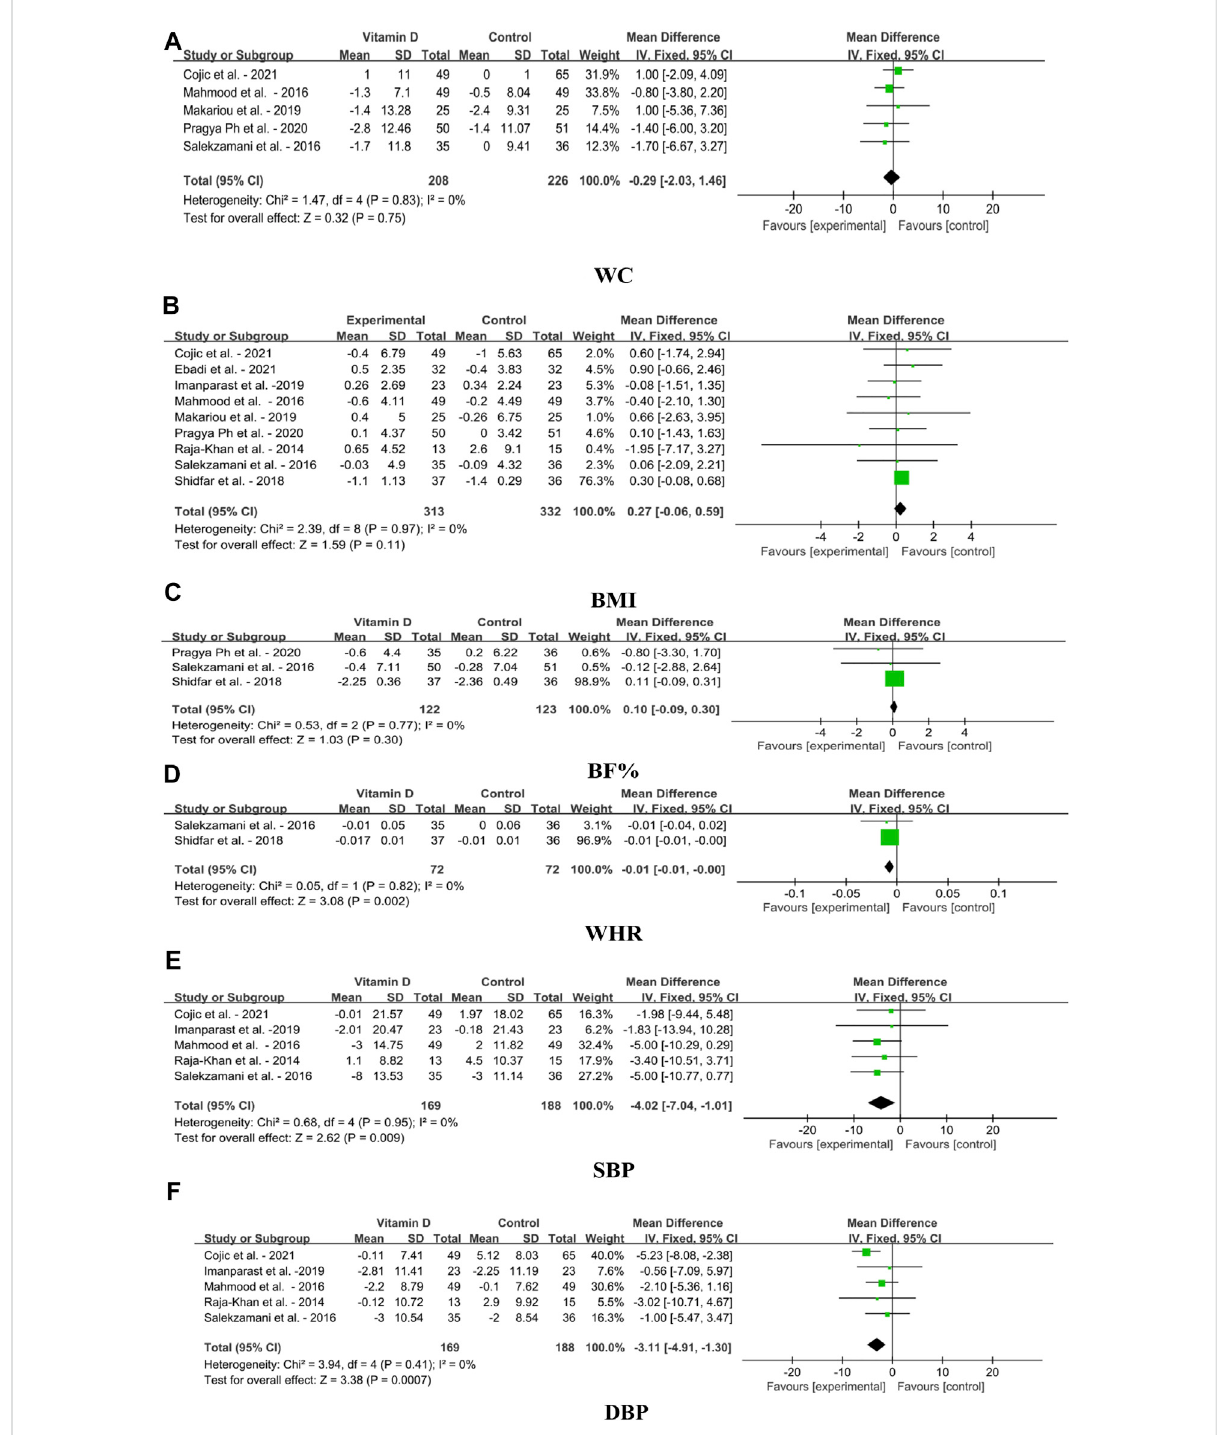
FIGURE 4 ForestplotsfortheeffectsofVDSonanthropometricparametersandbloodpressureinMetSadults. (A) WC:waistcircumference, (B) BMI:body mass index, (C) BF%: body fat percentage, (D) WHR: waist to hip ratio, (E) SBP: systolic blood pressure, (F) DBP: diastolic blood pressure. The horizontal bar indicates the 95% con fi dence interval (CI). The size of the rectangle at the center of the horizontal bar is proportional to the weight of the given study. The diamond at the bottom indicates the pooled mean difference